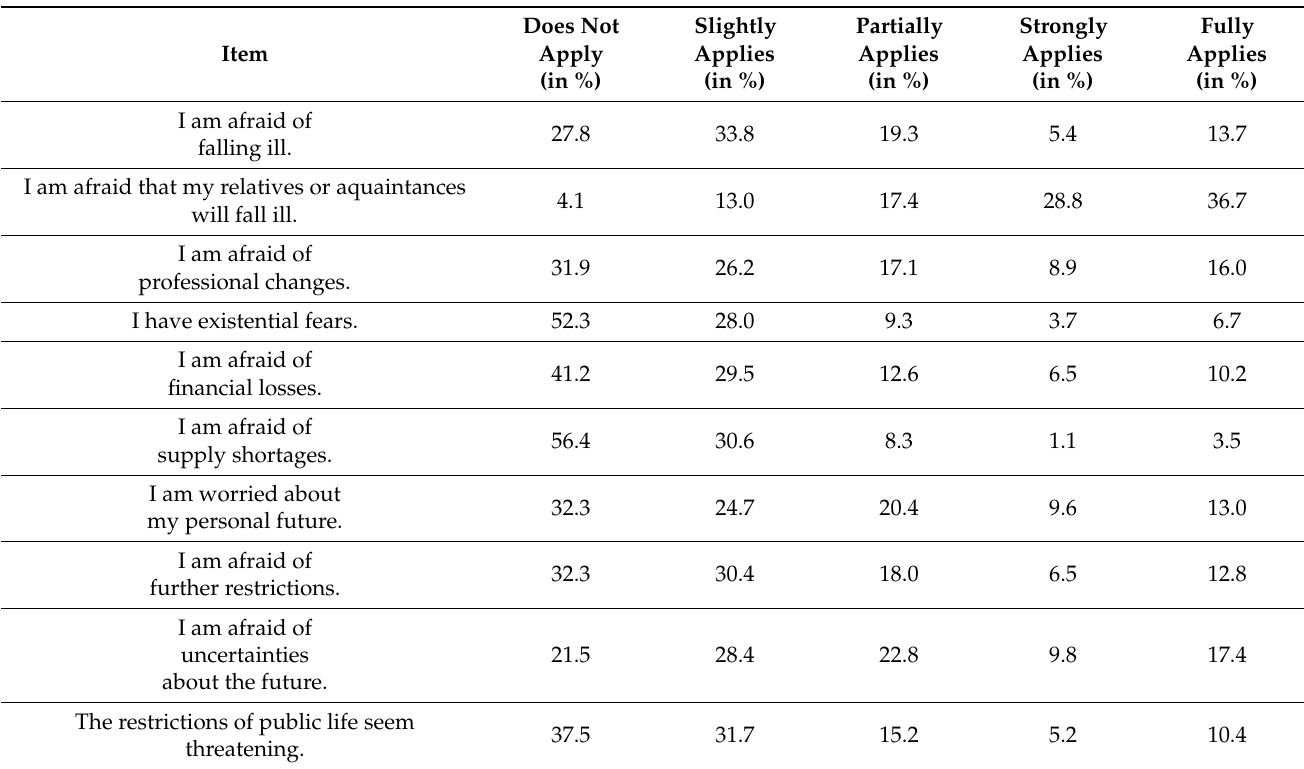
Table 5. Reported worries during the